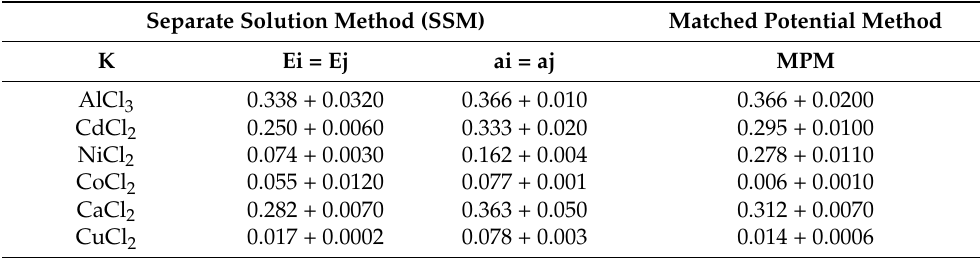
Table 2. The values of selectivity coefficients (K) of Al 3+ electrode.